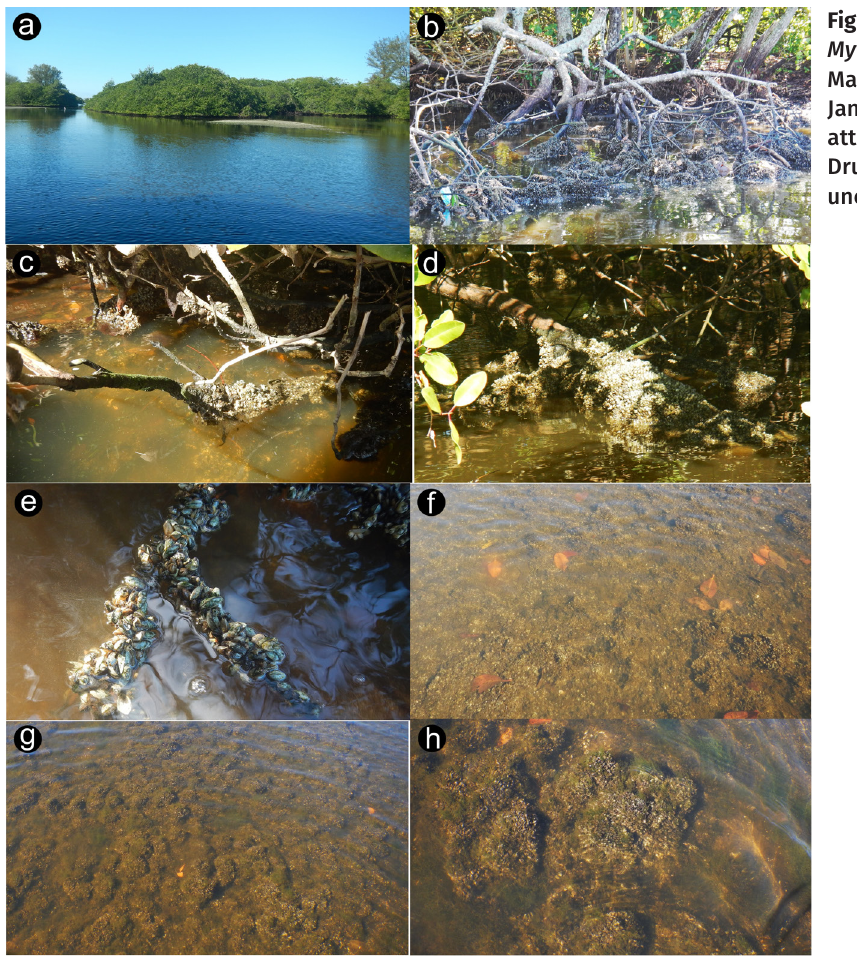
The 33 sequences of M . leucophaeata from Marapendi Lagoon clustered within the clade from Rio de Janeiro (Fernandes et al. 2018) and were set apart from the single haplotype from the Northern Hemisphere (Figure 5). Ten haplotypes were found in Marapendi Lagoon, of which five are shared with Rodrigo de Freitas Lagoon and five are exclusive from Marapendi, in addition to five exclusive from Rodrigo de Freitas (Figure 5).